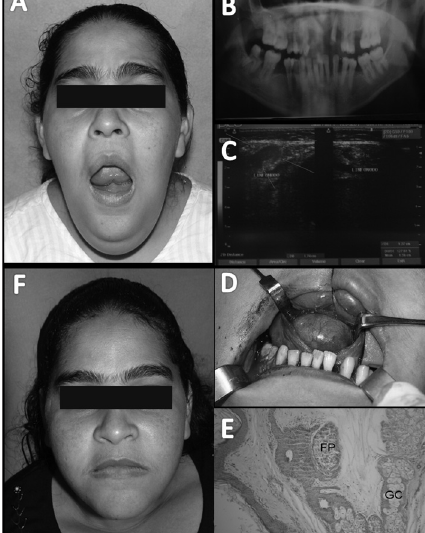
Figure 1. Dermoid cyst - A. Bilaterally enlarged submentual and submandibular mass resulting in a double chin, limited opening of the mouth, and elevated floor of the mouth; B. Panoramic radiograph of the jaws; C. Ultrasound - arrows show a suggested cyst with a semiliquid content within the fascial spaces of the muscles in the floor of the mouth; D. Surgical removal of the lesion through an intraoral approach; E. Histopathology. Note the wall of the cyst consisting of fibrous connective tissue, skin elements such as a hair follicle (PF), and sweat glands (SG) (H.E. 100x); F. Postoperative aspect after 1 year and 6